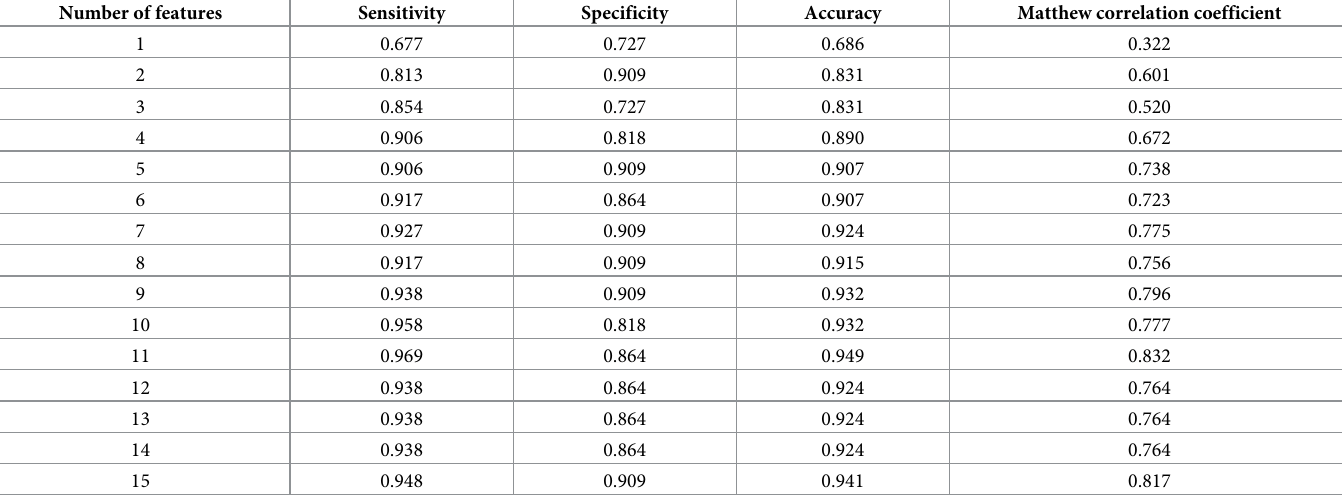
tackle the problem that control samples were much more than fetal intolerance sample. Obtained SNs, SP, ACCs and MCCs are listed in Tables 1–3 . For an easy observation, we plot- ted a curve for the IFS results with each classification algorithm, as shown in Fig 2 , in which MCC was set as Y-axis and the number of features was set as X-axis. For SVM, the highest MCC was 0.796, which was obtained by the top 10 features. Thus, we can build an optimum SVM model with these top 10 features. The other three measurements (SN, SP and ACC) of such model are listed in Table 2 . The highest MCC was 0.832 for RF when top 11 features were adopted. Accordingly, an optimum RF model was built with these top 11 features. The Table 1. IFS performance with RF and different top